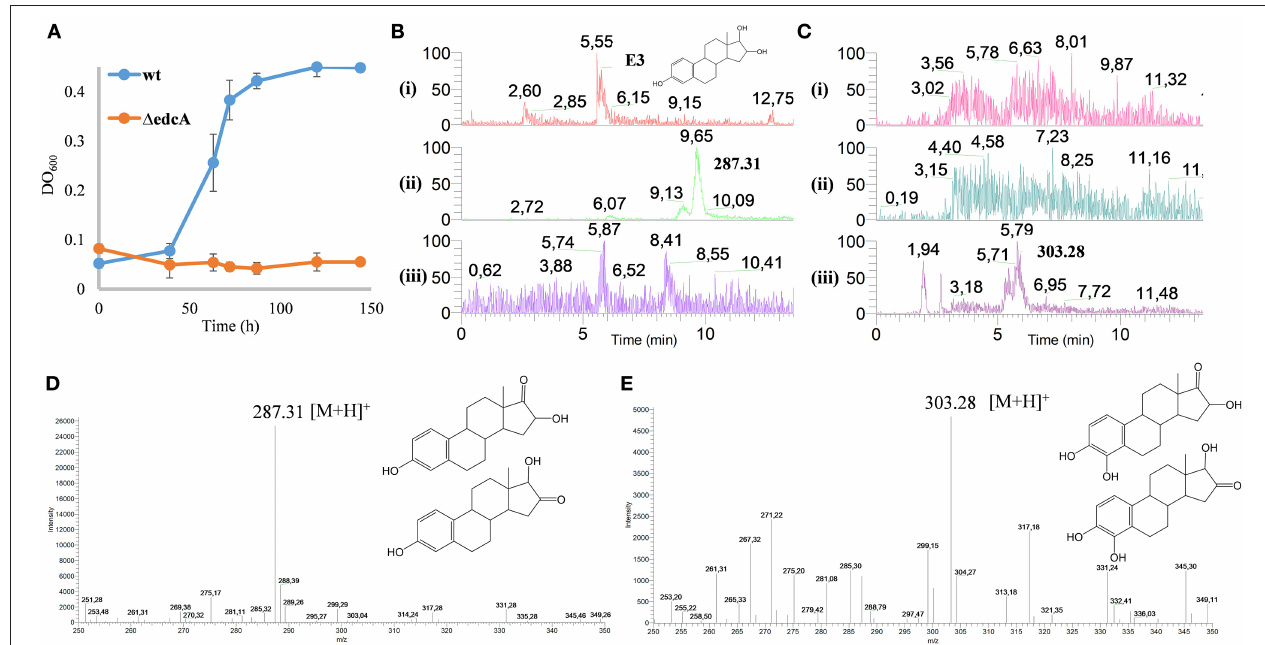
FIGURE 13 | (A) Growth curves (OD 600 ) on M63 minimal medium with 1.89mM E3 of N. tardaugens NBRC 16725 and 1 edcA. Data corresponding to biological triplicates and error bars show standard deviation. HPLC-MS analysis of the organic fraction extracted from cultures of N. tardaugens 1 Prom (pSEVA23-PlexA) and N. tardaugens 1 Prom (pSEVA23-edcA) in NB rich medium supplemented with 1.89mM E3, at 38h. Total ion chromatogram (TIC) of base peak m / z (B) 287 and (C) 303. The samples correspond to the control of non-inoculated medium, (i); N. tardaugens 1 Prom (pSEVA23-PlexA) strain, (ii); and N. tardaugens 1 Prom (pSEVA23-edcA) strain, (iii). Mass spectrum of the peak observed at (D) 9.65min and (E) at